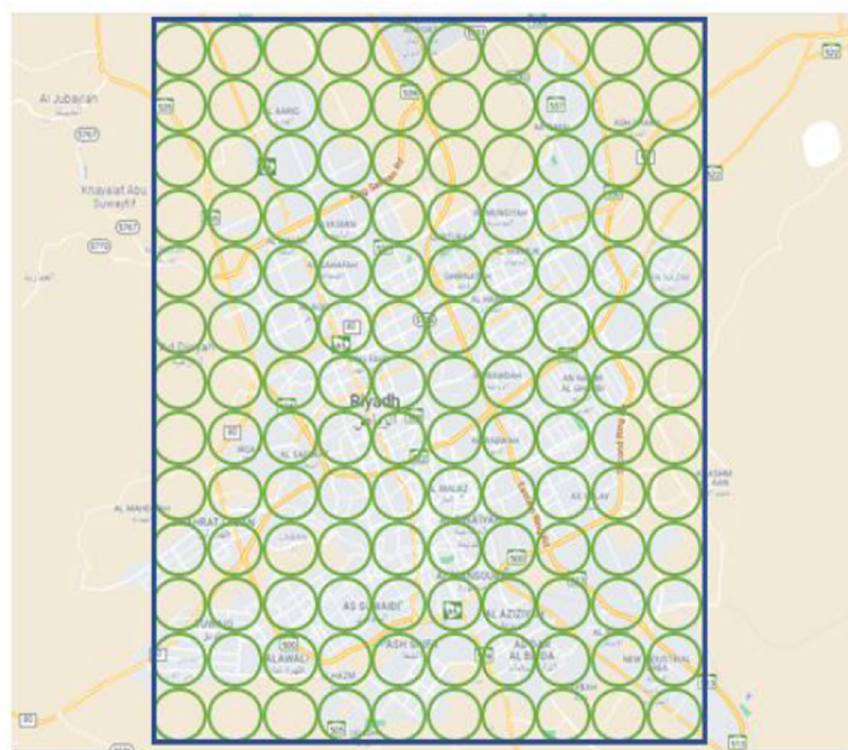
Fig. 7 Location inference by dividing the area into small circular zones